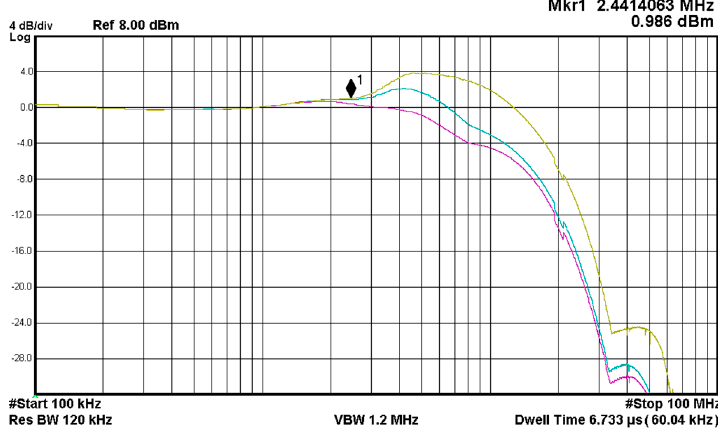
Figure 14. The experimental evidence frequency ranges of AD844 when R 1 = R 2 = 1 k Ω (yellow line; R 1 = R 2 = 5 k Ω (cyan line); and R 1 = R 2 = 10 k Ω (purple line).